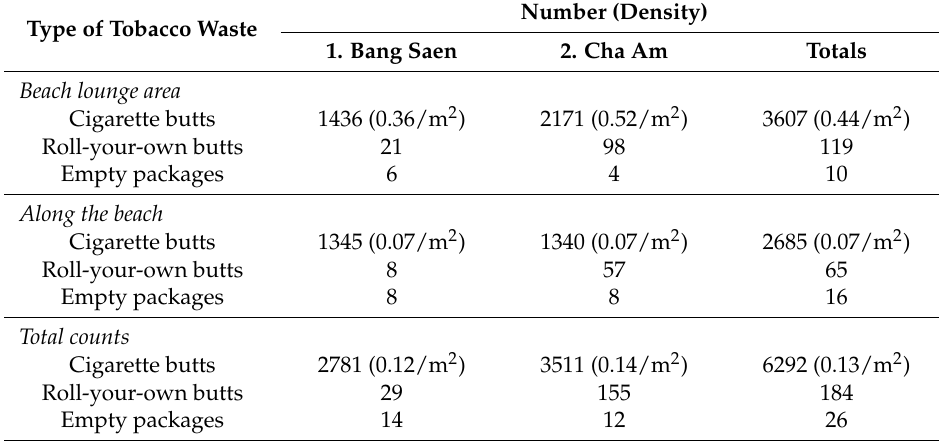
Table 1. Density of cigarette butts on the surface of sand at two popular public beaches in Thailand.